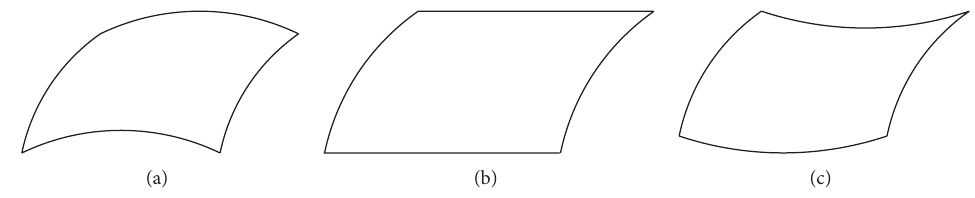
Figure 1: Shells of positive, zero, and negative Gaussian curvature: (a) spherical, (b) circular cylindrical, and (c) hyperbolic paraboloidal.